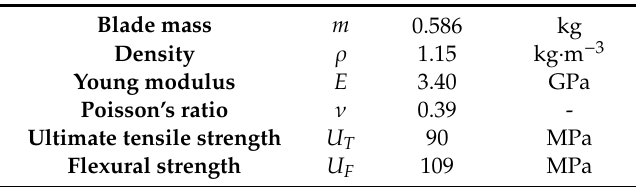
Table 1. Blade and material